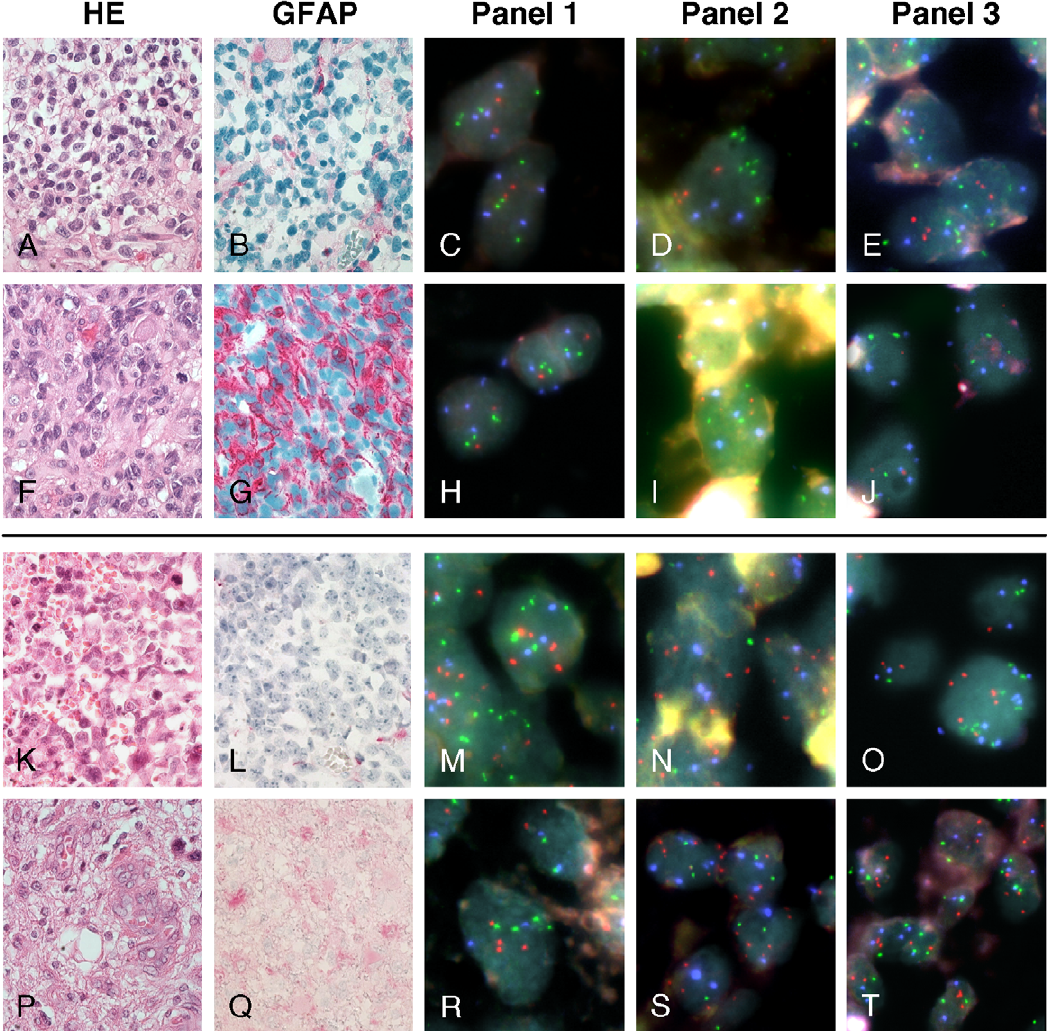
Fig. 1. Histological appearance and Interphase-FISH results of the oligodendroglial and astrocytic parts of one GBMO-H and one GBMO-R exemplifying the principle approach. First row: Oligodendroglial component of one GBMO-H (ID11) with typical clear cells and honeycomb appearance in the H&E-stain ( × 200) (A) and lack of GFAP in the immunohistochemistry ( × 200) (B). Interphase-FISH ( × 400) revealed triploid tumor cells (D: 3 blue signals for cen18) with + 1p (C, E: 4 green signals), + 1q (E: 4 blue signals), + 7q (D: 4 red signals), + 10q (D: 5 green signals), + 21q (C: 4 blue signals) and − 19q (C: 2 red signals). The “classic” glioblastoma part of the same tumor (second row) showed astrocytic like cells in the H&E-stain (F), which were mostly GFAP-positive (G). The tumor cells had + 1q (J: 4 blue signals), + 21q (H: 4 blue signals), − 17p (J: 2 red signals), − 19q (H: 2 red signals), but a normal 1p (H: 2–3 green signals), 7q and 10q (I: 3 green and red signals) in most tumor cells. In addition, the cells showed + cen18 (I: 4 blue signals). K–T give an example for one GBMO-R (ID9): The oligodendroglial part (third row) consisted of round, uniform, GFAP-negative tumor cells (K, L). Most nuclei were triploid (M, N: 3 blue signals for 21q and cen18) with + 1p (M, O: 5 green signals), + 1q (O: 5 blue signals), + 7q (N: 5 red signals), + 17p (O: 5 red signals), + 19q (M: 5 red signals) and − 10q (N: 1 green signal). In contrast, the astrocytic part of the same tumor (fourth row) showing classical GBM features (including vascular proliferation) in the H&E-stain (P) and GFAP-positivity (Q) consisted of diploid nuclei (R: 2 blue signals for 21q) with + 1p (R, T: 4 green signals), + 1q (T: 3–4 blue signals), + 7q (S: 4 red signals), + 17p (T: 3 red signals), + 19q (R: 4 red signals) and − 10q (S: 1 green signal). Recognize the different cell clones in one tumor area: For example, + cen18 and − 10q was present only in a proportion of tumor cells (S: 2 or 3 blue signals, 1 or 2 green signals). Also a differing proportion of cells showed no genetic changes as it is seen, for example, in R and T (each 2 signals for the DNA-probes in green, red and